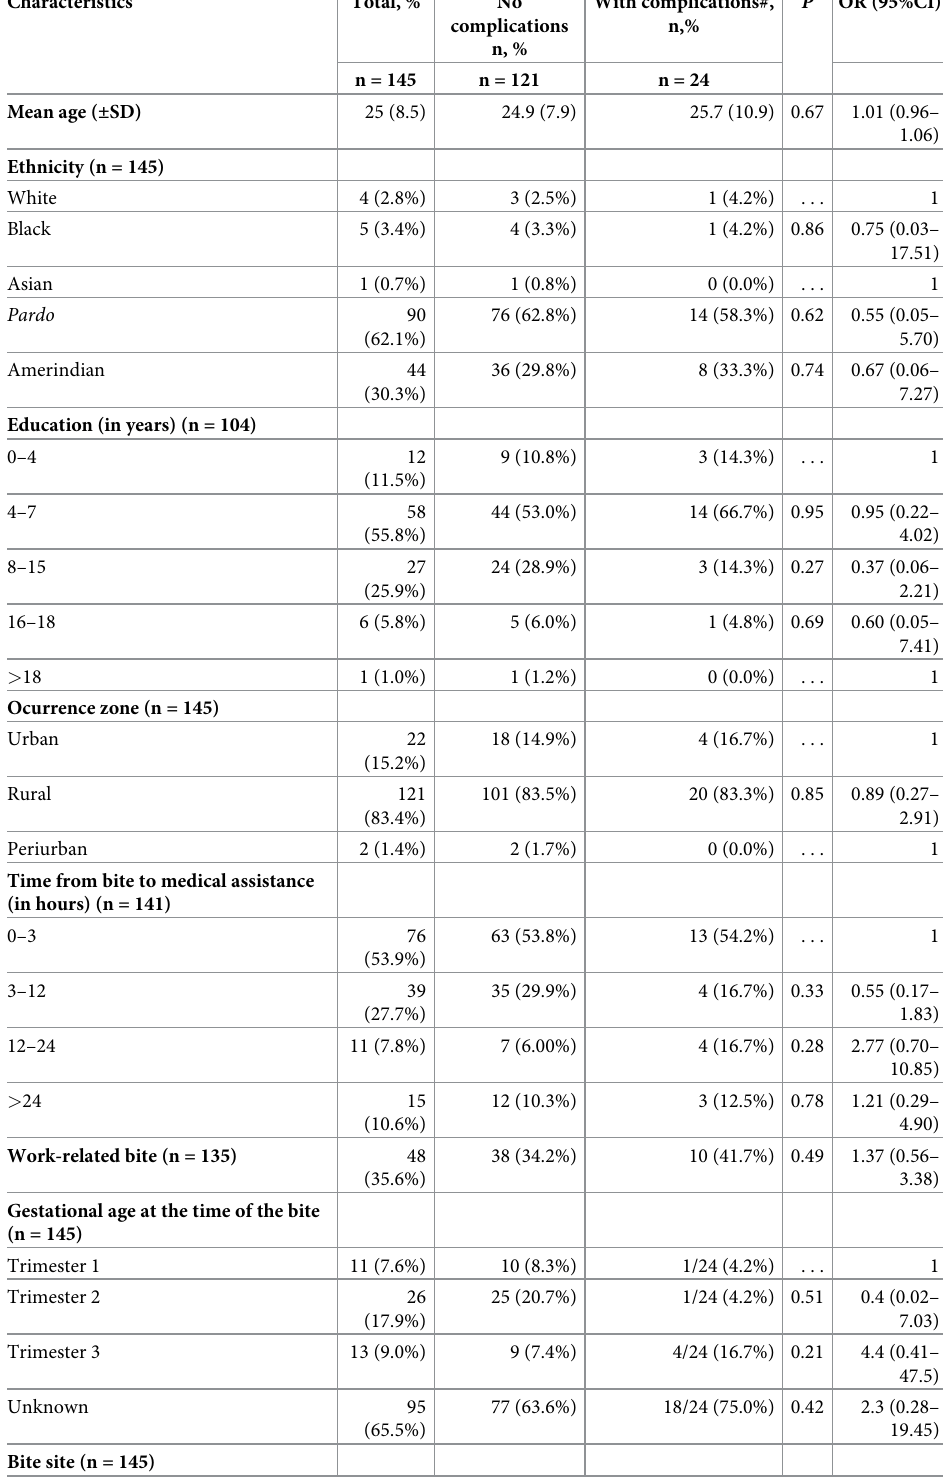
Table 3. Demographic and clinical aspects between pregnancy with complications and no